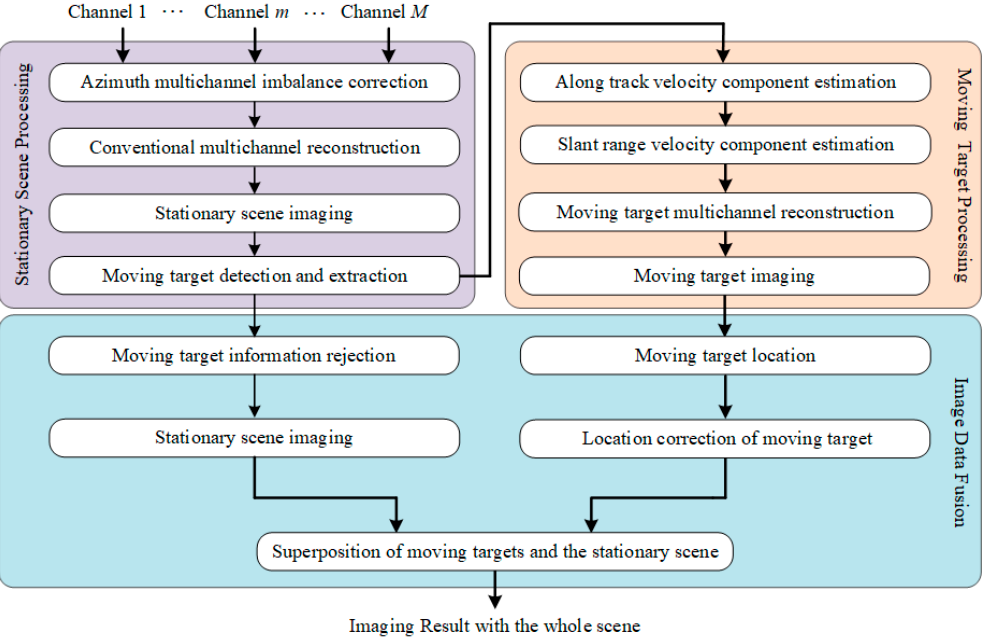
Figure 13. The flowchart of the proposed imaging approach for moving targets in azimuth multichannel GEO-SAR-BiSAR.